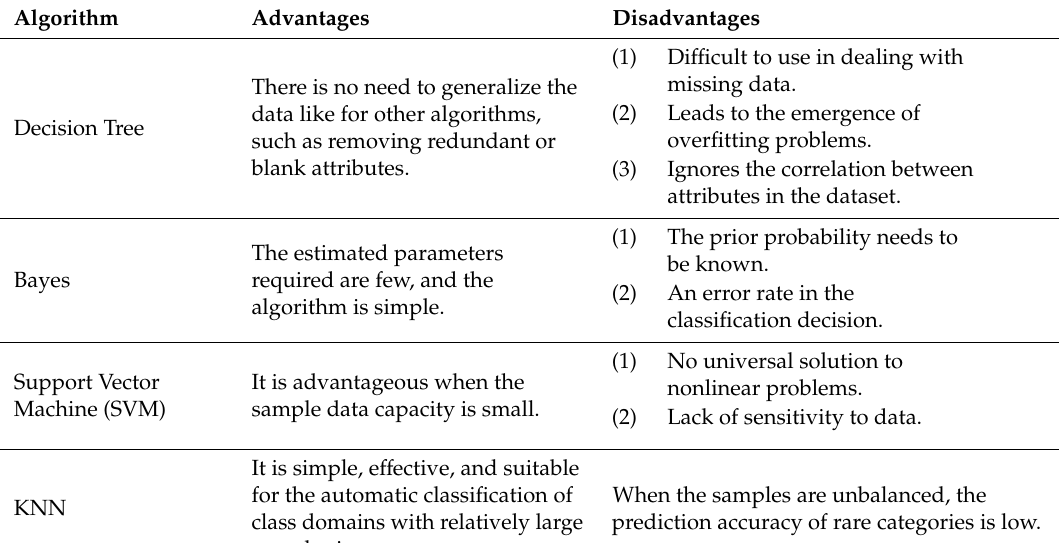
Table 1. Advantages and Disadvantages of each